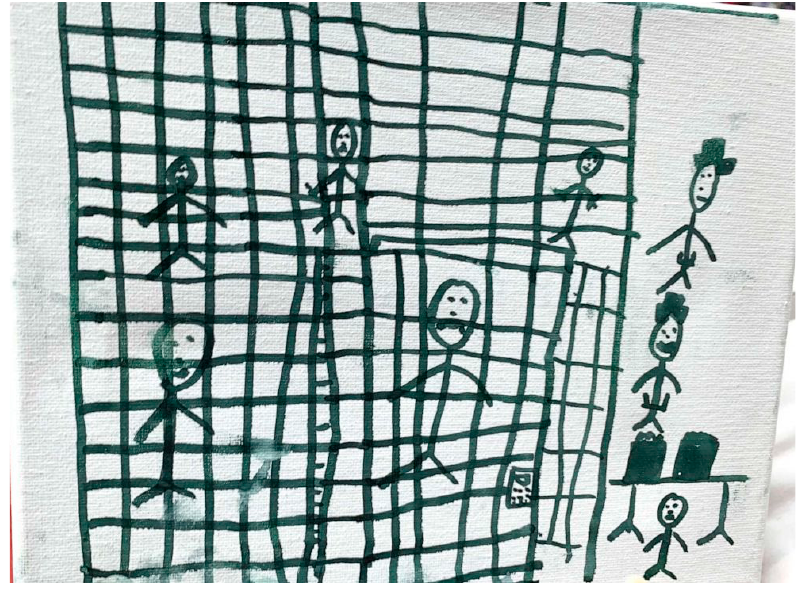
Figure 5. Drawing by primary school age boy held in an unspecified US detention Center, 2019. Courtesy of American Academy of Pediatrics.